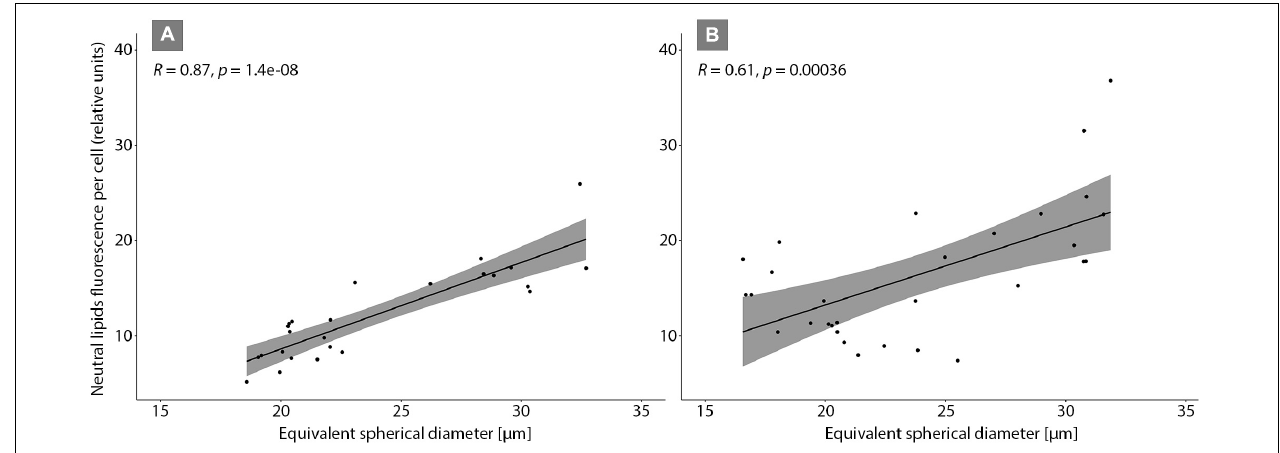
FIGURE 5 | Correlation plot of Schizostauron spp. cell sizes and neutral lipid fluorescence measured using flow cytometer on day 13 (A) and day 14 (B) .